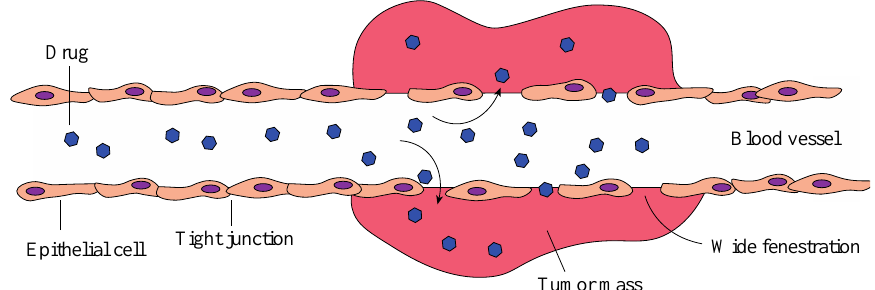
Figure 17. Schematic representation of the EPR effect.